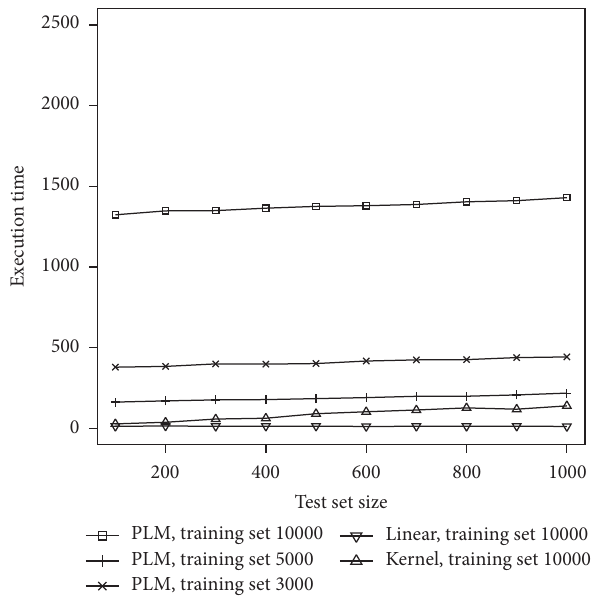
Figure 8: Execution time dependence on test set size for airlines data.